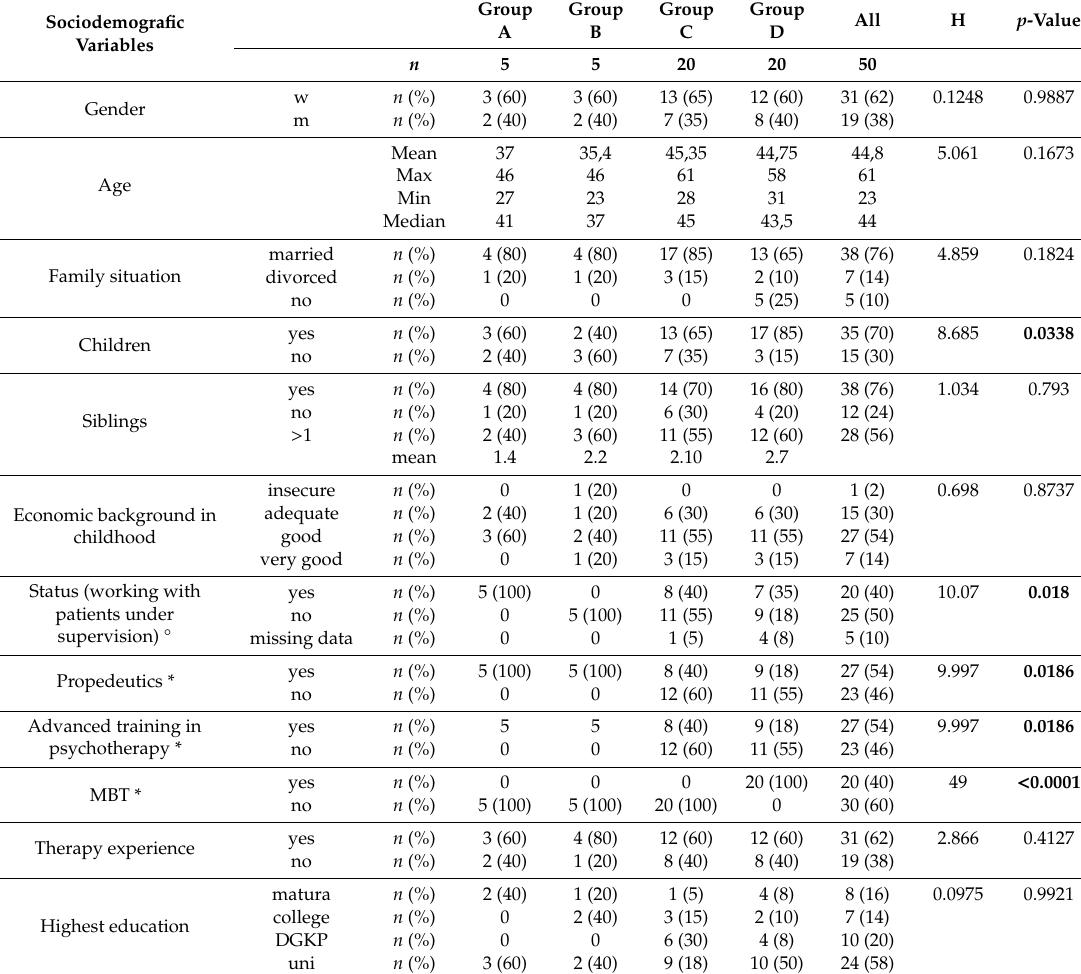
Table 1. Demographical characteristics of the